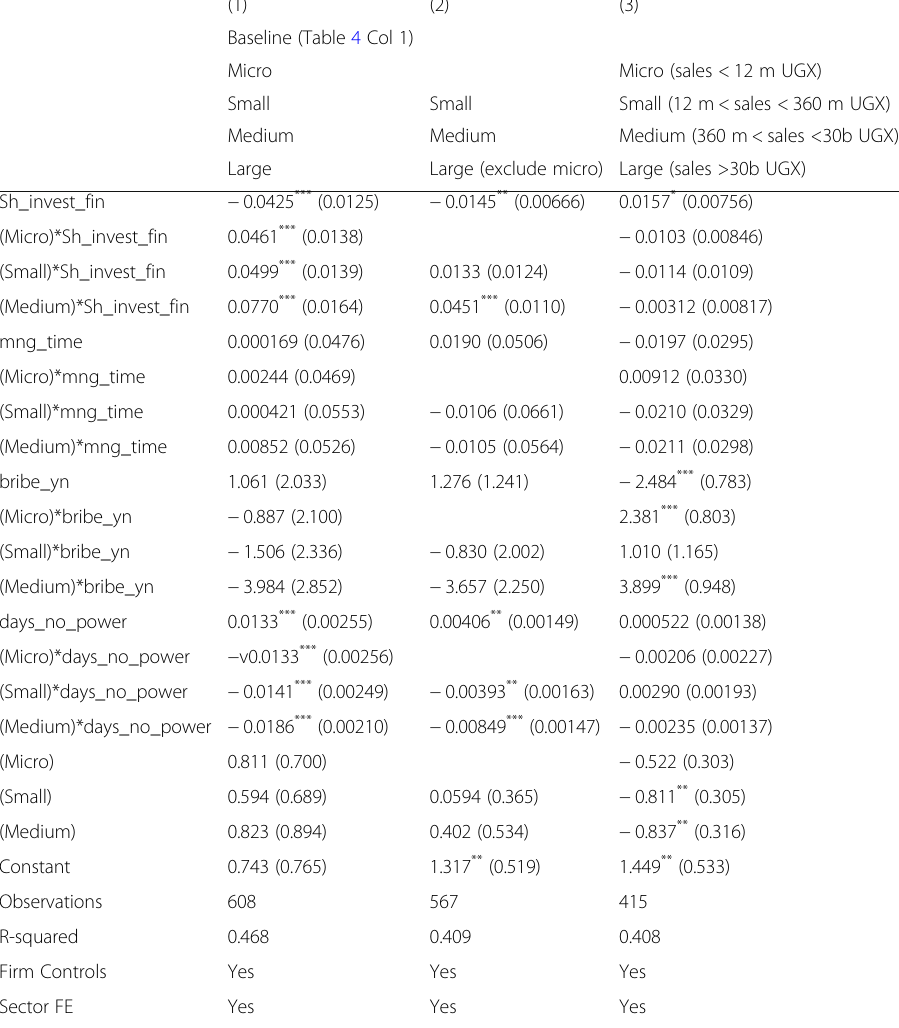
Table 7 Other size